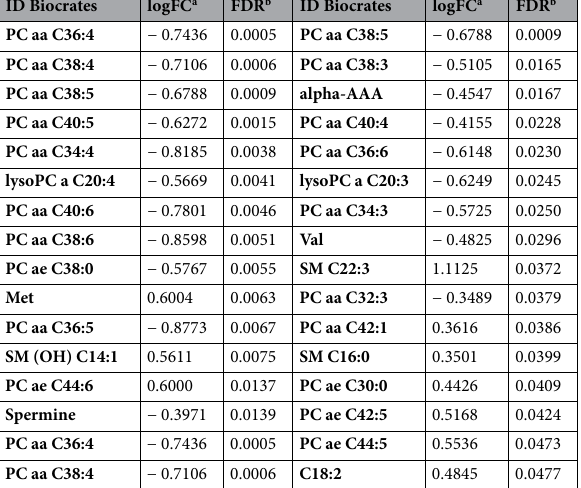
Table 1. Serum metabolites with significant differences between patients with and without MHE. Lipids are described with the notation “Cx:y”, where x denotes the number of carbons in the side chain and y